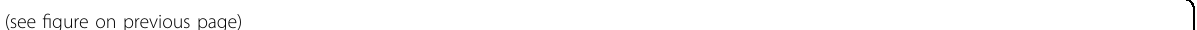
Fig. 5 Identi fi cation of miRNAs binding to hsa_circ_101555 that modulate the proliferation, cell cycle, migration, and invasion of HCC cells via miR-145-5p. A Heatmap analyses exhibit differentially expressed miRNAs in HCC with |log2fold-change | > 1.0 and P < 0.05. B Venn analysis between predicted miRNA targeted by hsa_circ_101555 and differentially expressed miRNAs implying that miR-145-5p is involved in HCC. C Kaplan – Meier curves imply that patients with low miR-145-5p levels have a poorer 10-year overall survival. D Expression of miR-145-5p in 10 HCC tumor tissues and adjacent normal tissues, measured by qRT-PCR (*** P < 0.001). E Pearson correlation analyses showing a correlation between hsa_circ_101555 and miR-145-5p expression ( n = 20). F , G Schematic of hsa_circ_101555 wild-type (wt) and mutant (mut) luciferase reporter vectors. Luciferase reporter assay in HEK293T cells co-transfected with miRNA mimics, hsa_circ_101555-wt and mutant (mut) luciferase reporter vectors. H Expression of miR-145-5p analyzed by qRT-PCR in HCCLM3 and HepG2 cells transfected with siRNA-hsa_circ_101555-#1, siRNA-hsa_circ_101555-#3, or siRNA-NC (** P < 0.01; *** P < 0.001; n = 5). I , J Viability of HCCLM3 and HepG2 cells after co-transfection with siRNA-hsa_circ_101555 and miR-145- 5p inhibitor measured using WST-1 assays (* P < 0.05;** P < 0.01; *** P < 0.001; n = 4). K , L Cell proliferation ability of HCCLM3 and HepG2 cells co- transfected with siRNA-hsa_circ_101555 and miR-145-5p inhibitor evaluated by colony formation assay (* P < 0.05;** P < 0.01; *** P < 0.001; n = 4). M , N Cell migration or invasion assays performed in HCCLM3 and HepG2 cells co-transfected with siRNA-hsa_circ_101555 and miR-145-5p inhibitor using transwell chamber, with or without Matrigel, respectively (** P < 0.01; *** P < 0.001; n =